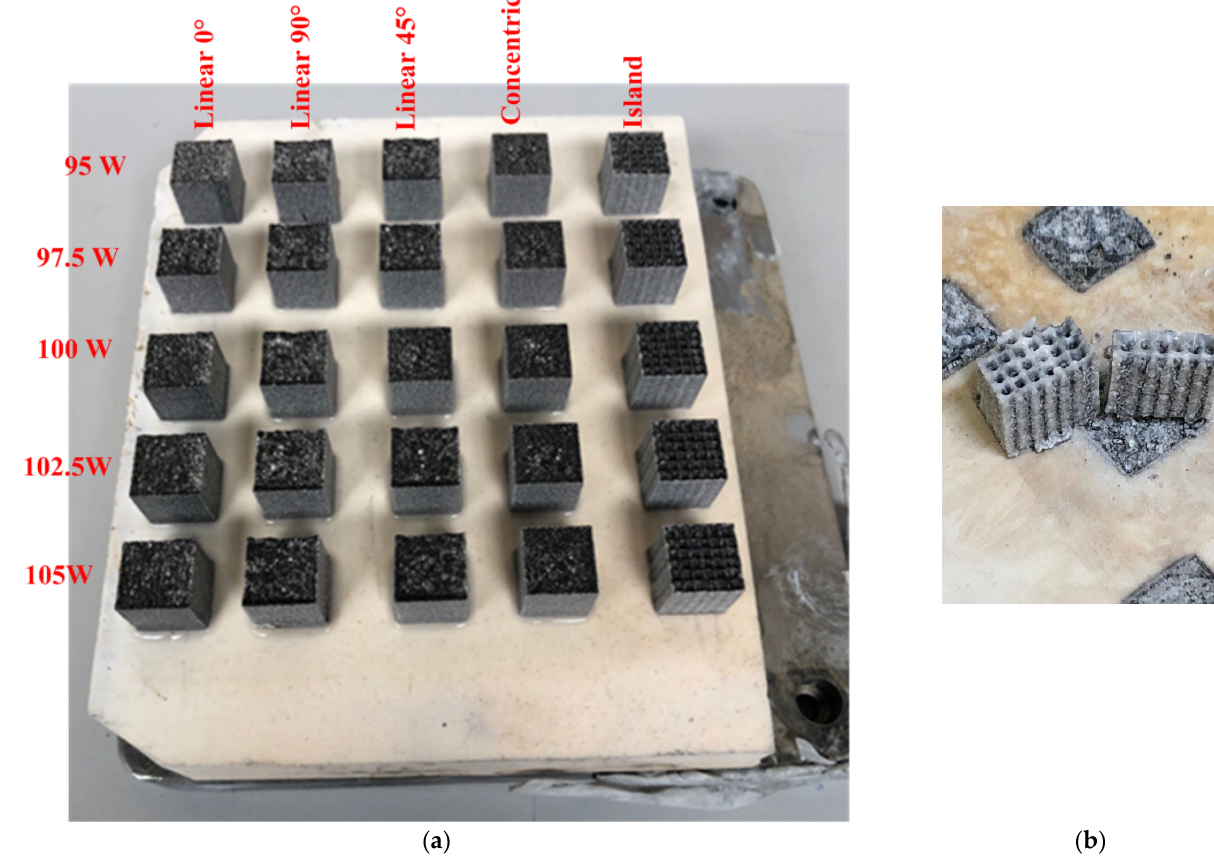
Figure 18. ( a ) Alumina samples (10 × 10 × 10 mm 3 ) printed with different scanning strategies and laser power; ( b ) a broken alumina sample printed using island-concentric out-in strategy containing the round passages.